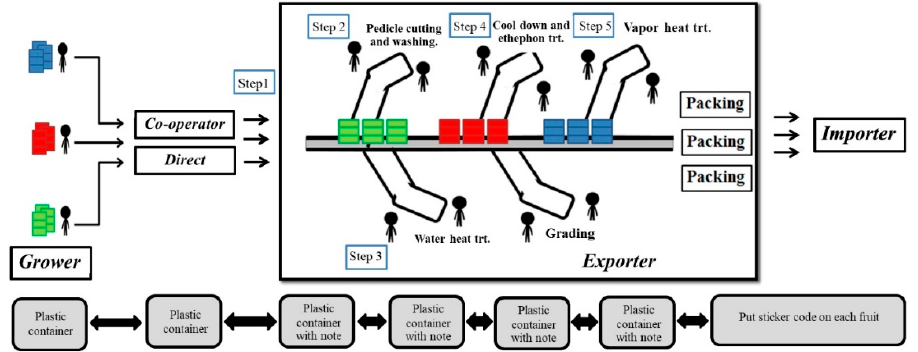
Figure 4. Overview of material and information flows of mango production process in the pilot export company .